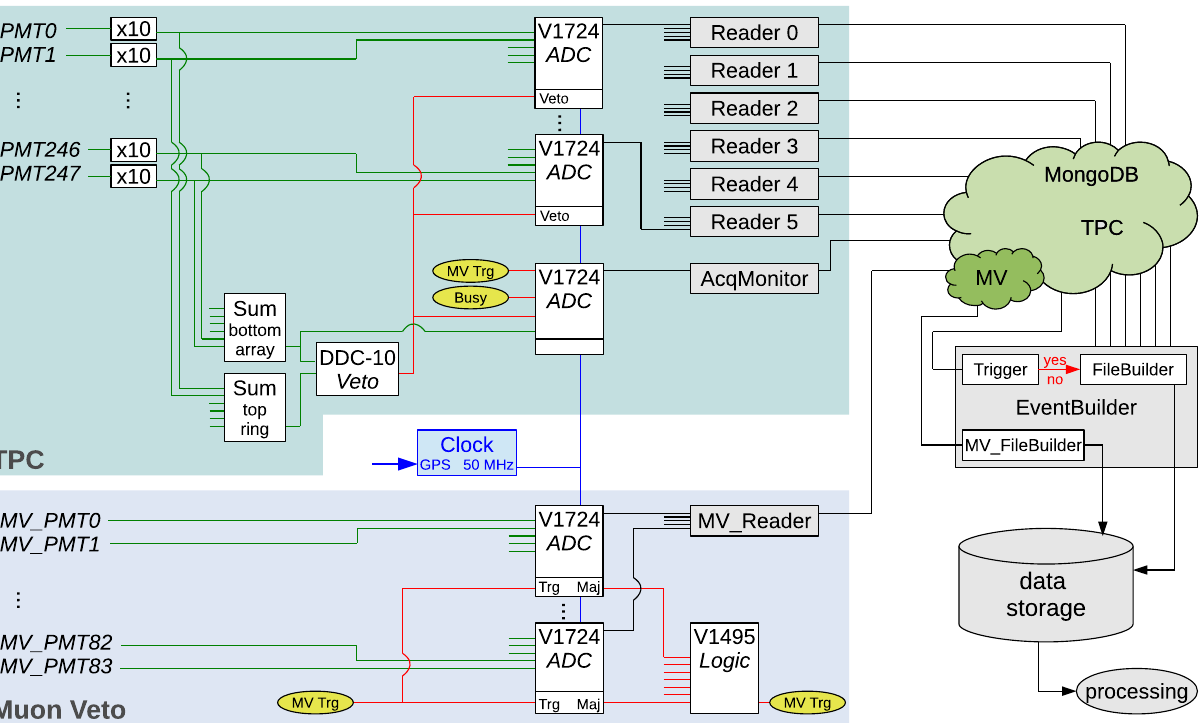
Fig. 13 Illustration of the XENON1T DAQ system for the TPC and the muon veto. The two detectors are time-synchronized. The acquisi- tion monitor consists of one high-data bandwidth ADC which records